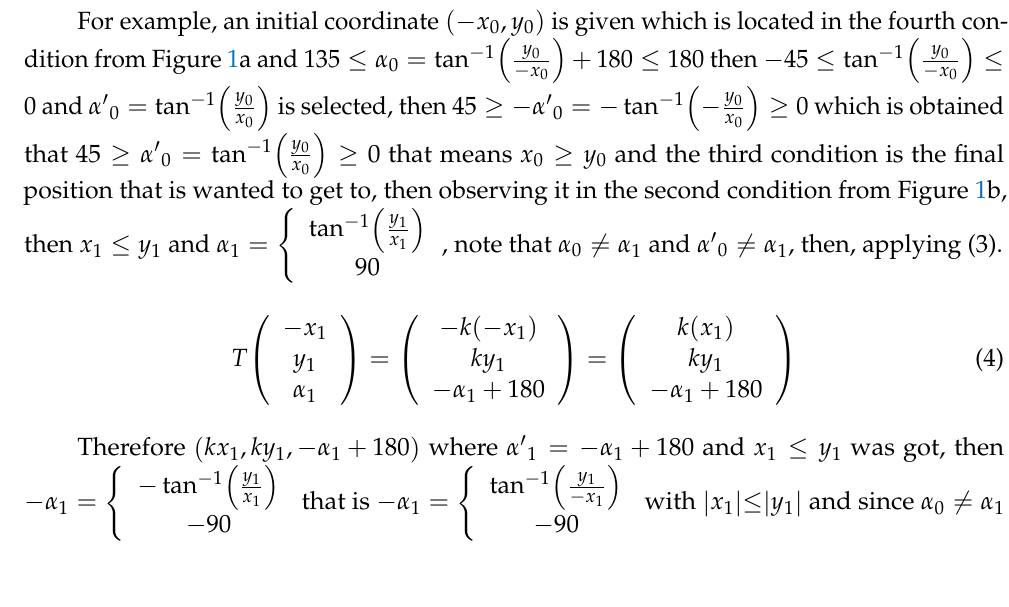
Figure 1. Representation of the four conditions and the two linear transformation. ( a ) First linear transformation. ( b ) Second linear transformation.